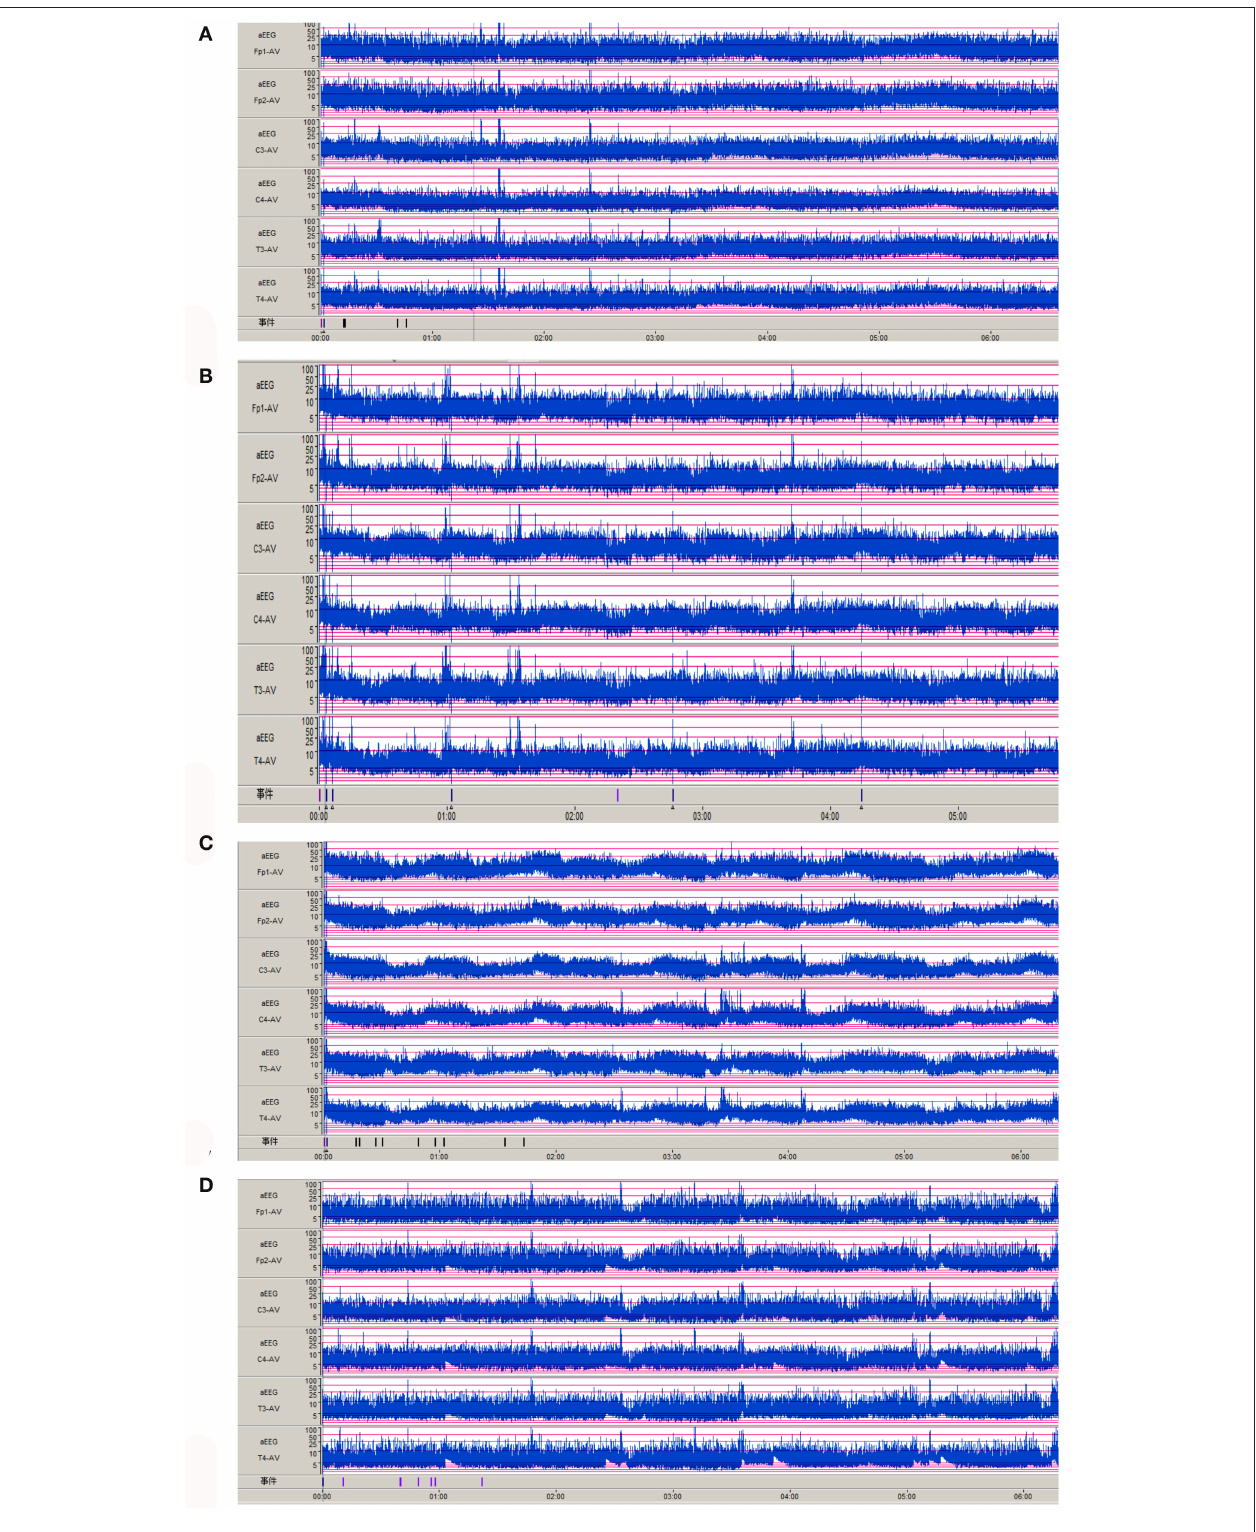
FIGURE 2 | Abnormal aEEG manifestations of Neonatal HFMD complicated with Encephalitis. (A–D) : the background activity of aEEG is a discontinuous pattern.